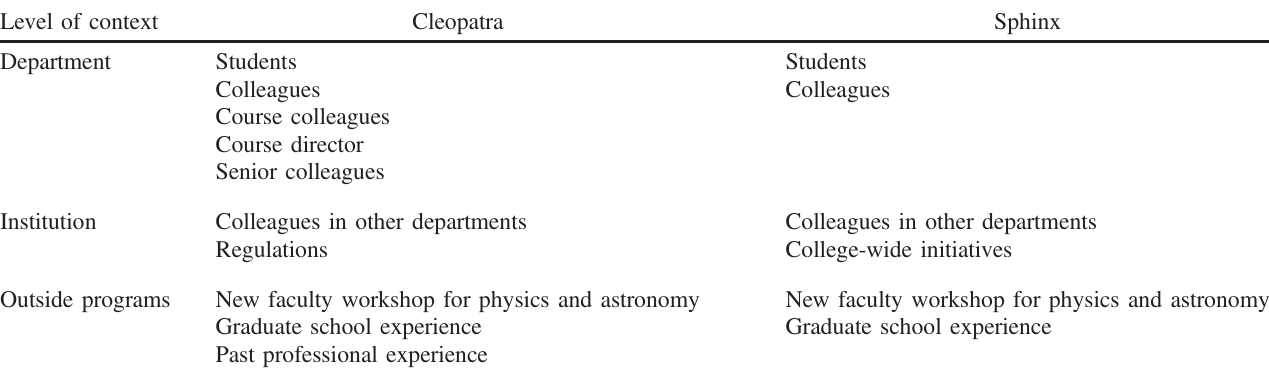
TABLE I. Elements of the three levels of context for Cleopatra and Sphinx.